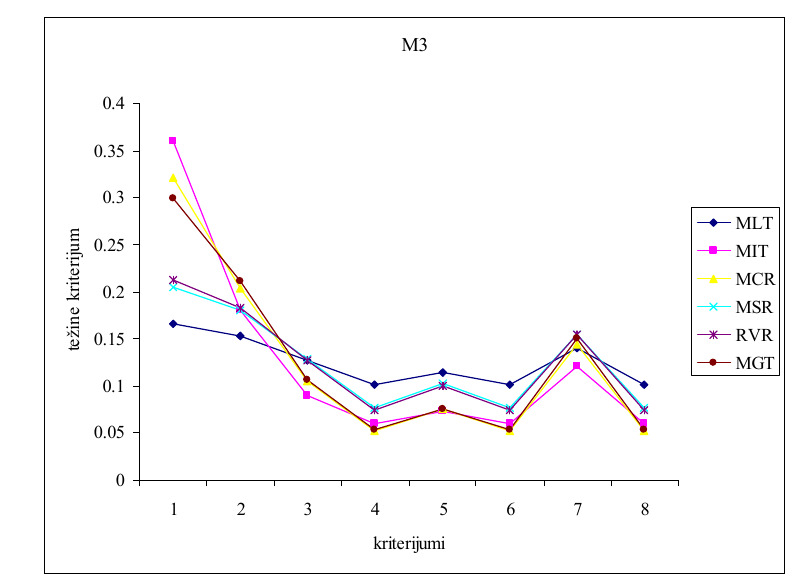
Figure 9 – Graph of the median ranks criteria